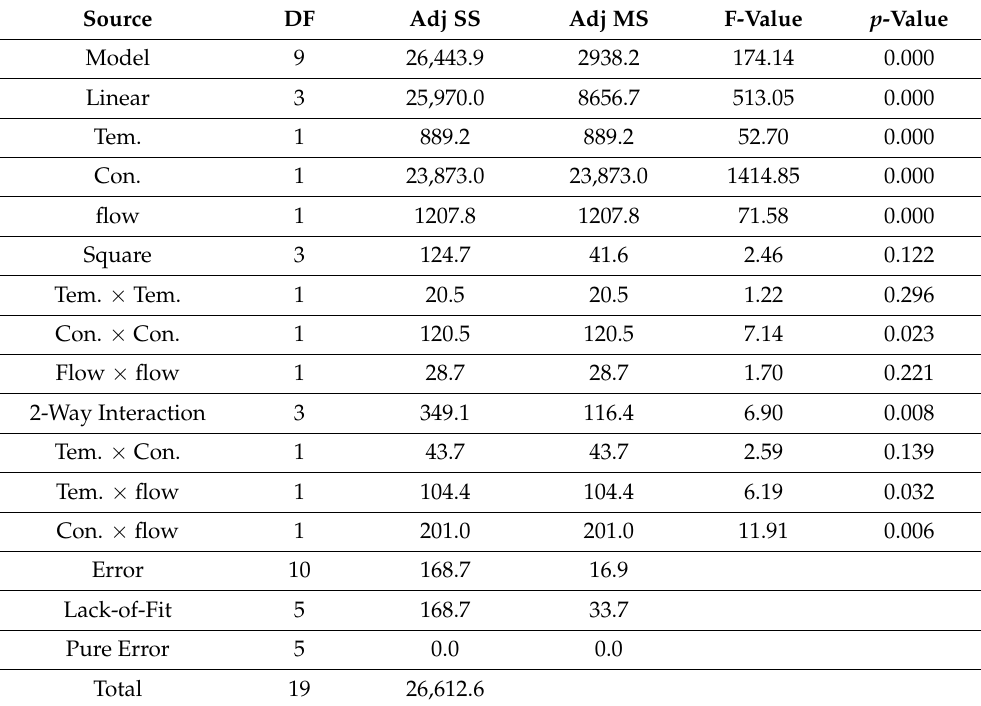
Table 3. Analysis of variance for toluene permeate flux.